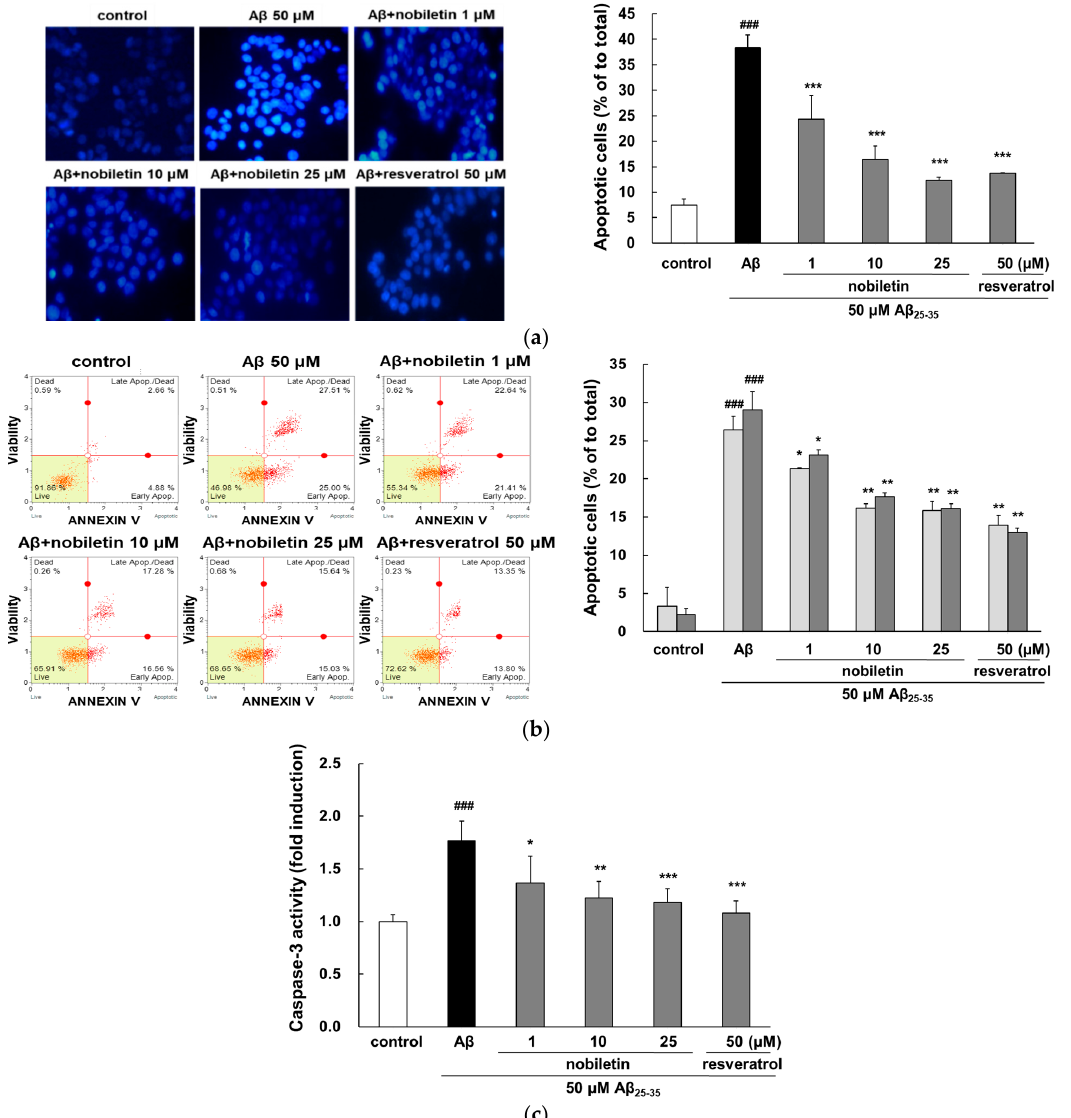
Figure 2. Activity of nobiletin in preventing A β 25-35 -evoked apoptosis and caspase-3. ( a ) Morphological features of apoptotic cells were observed by fluorescence microscopy using Hoechst 33342 staining (magnification ×400). ( b ) Flow cytometric analysis was used to investigate the properties of nobiletin on A β 25-35 -stimulated apoptosis. The cell populations discriminated in each quadrant are live cells in the lower-left quadrant, early apoptotic cells in the lower-right quadrant, late apoptotic cells in the upper-right quadrant, and dead cells in the upper-left quadrant. ( c ) Caspase-3 activity was assessed using the caspase-3 assay kit. ### p < 0.001 vs. control. *** p < 0.001, ** p < 0.01, and * p < 0.05 vs. A β 25–35 .